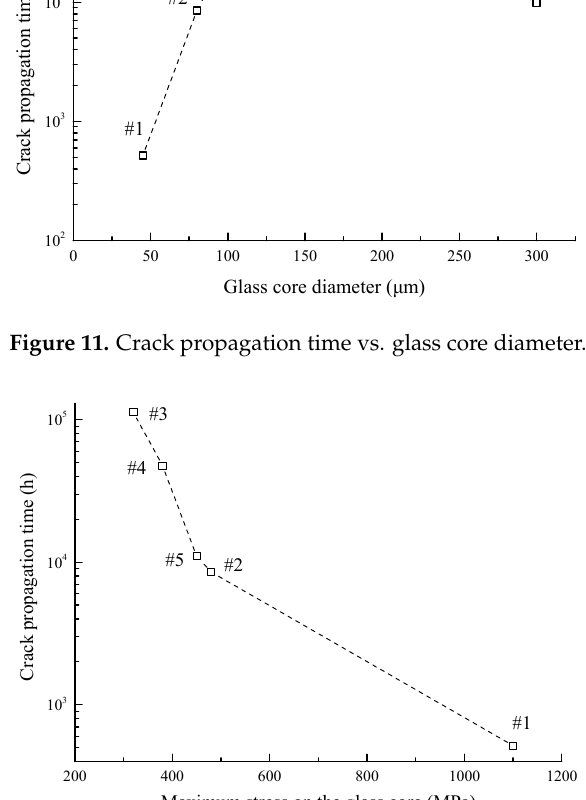
Figure 12. Crack propagation time vs. maximum stress on the glass core.